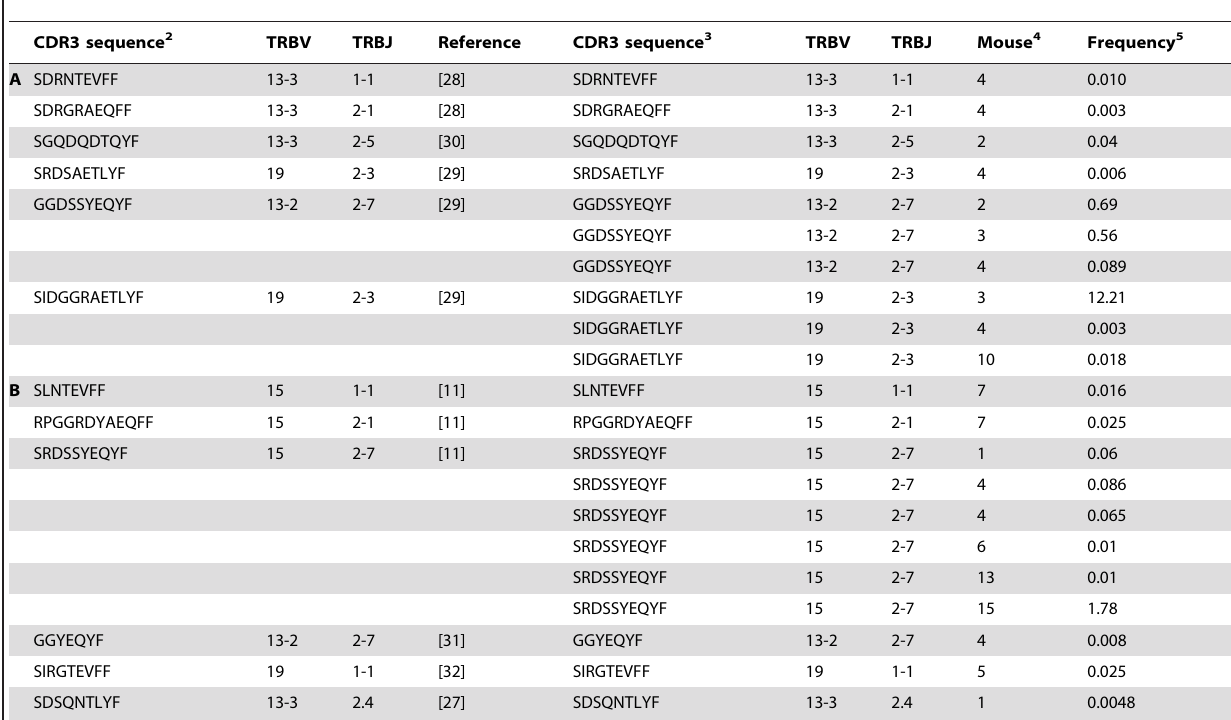
Table 4. Comparison of published CDR3 b sequences with CDR3 b sequences from islet-infiltrating CD4 + CD44 high T cells 1 .